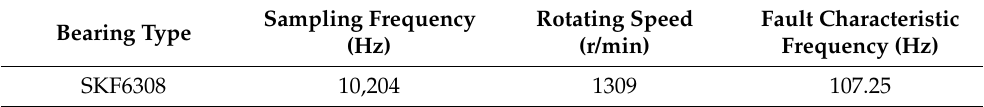
Table 3. Bearing